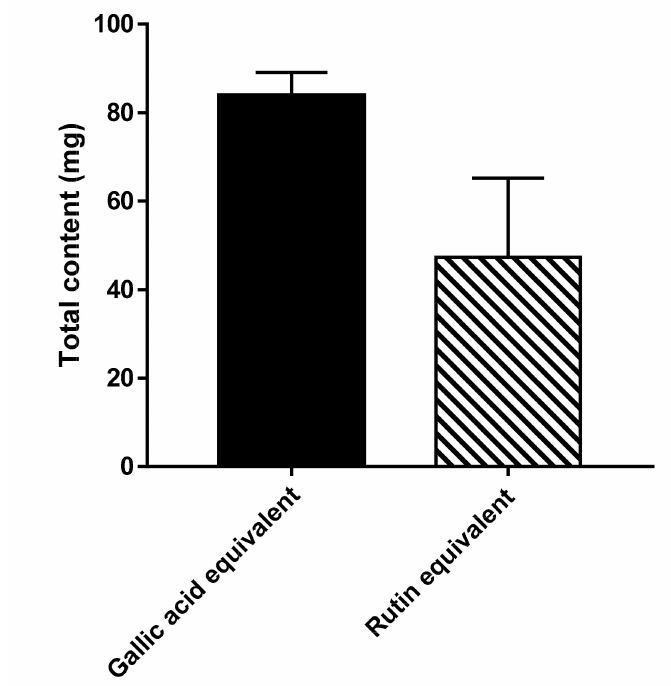
Figure 1. C. annua total phenolics contents (TPC) expressed as gallic acid equivalent per gram of dry weight GAE / g dw (83.8%) and total flavonoids contents (TFC) expressed as rutin equivalent per gram of dry weight RE / g dw